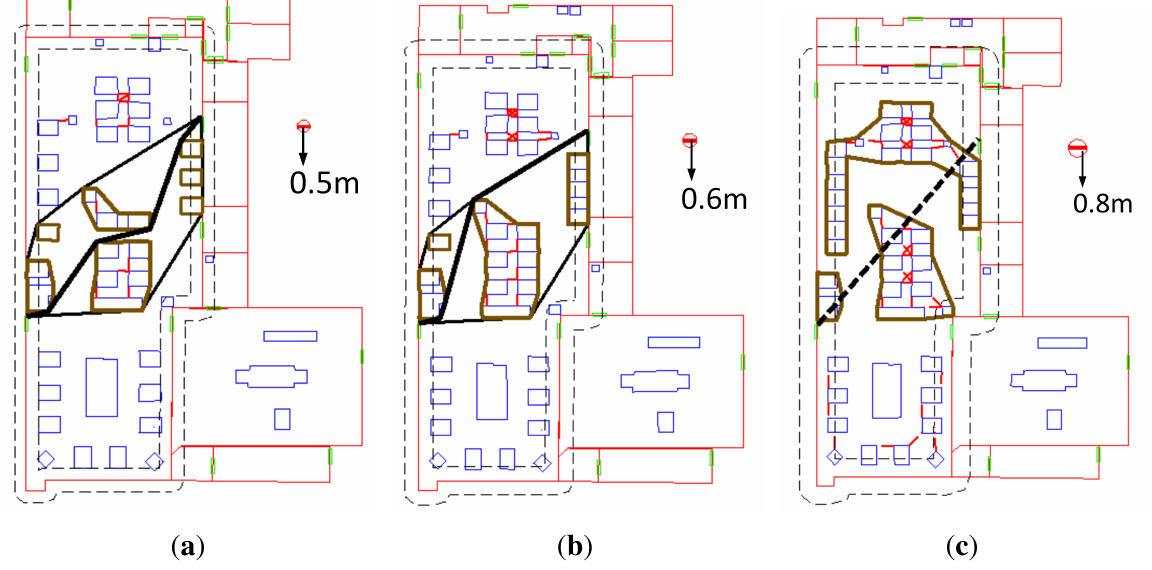
Figure 15. Path-finding for the sizes of 0.5 m, 0.6 m and 0.8 m on the hospital floor plan. ( a ) The shortest path for the 0.5 m size; ( b ) the shortest path for the 0.6 m size; ( c ) no path for the 0.8 m size.